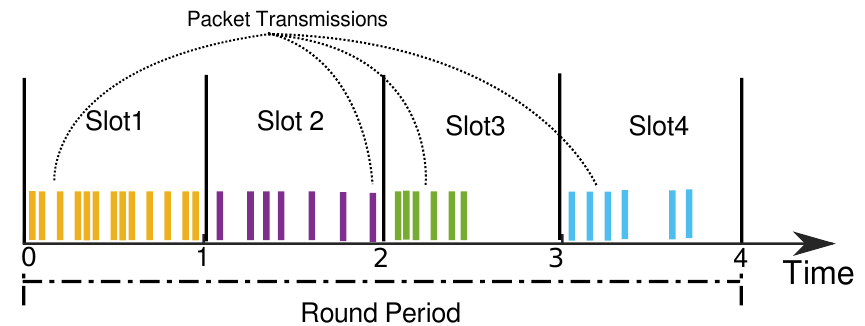
Figure 2. TDMA allows each node to send packets in its own slot. Each of the vertical colored bars represents a packet